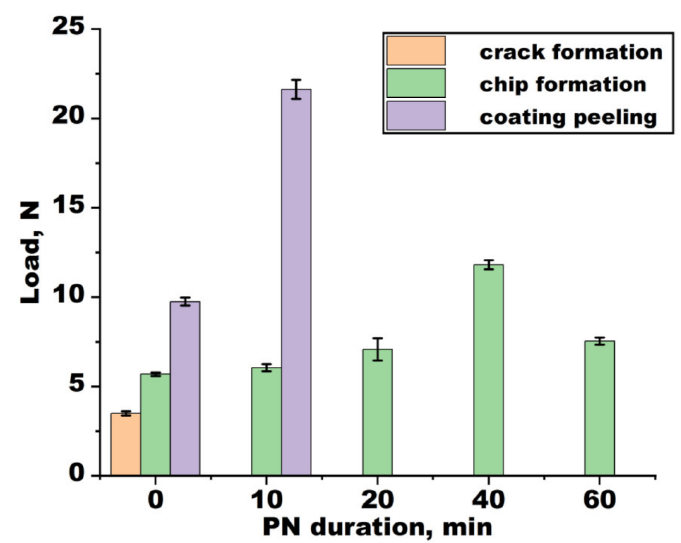
Figure 9. The critical loads of first crack formation, coating chipping, and spallation depending on the PN